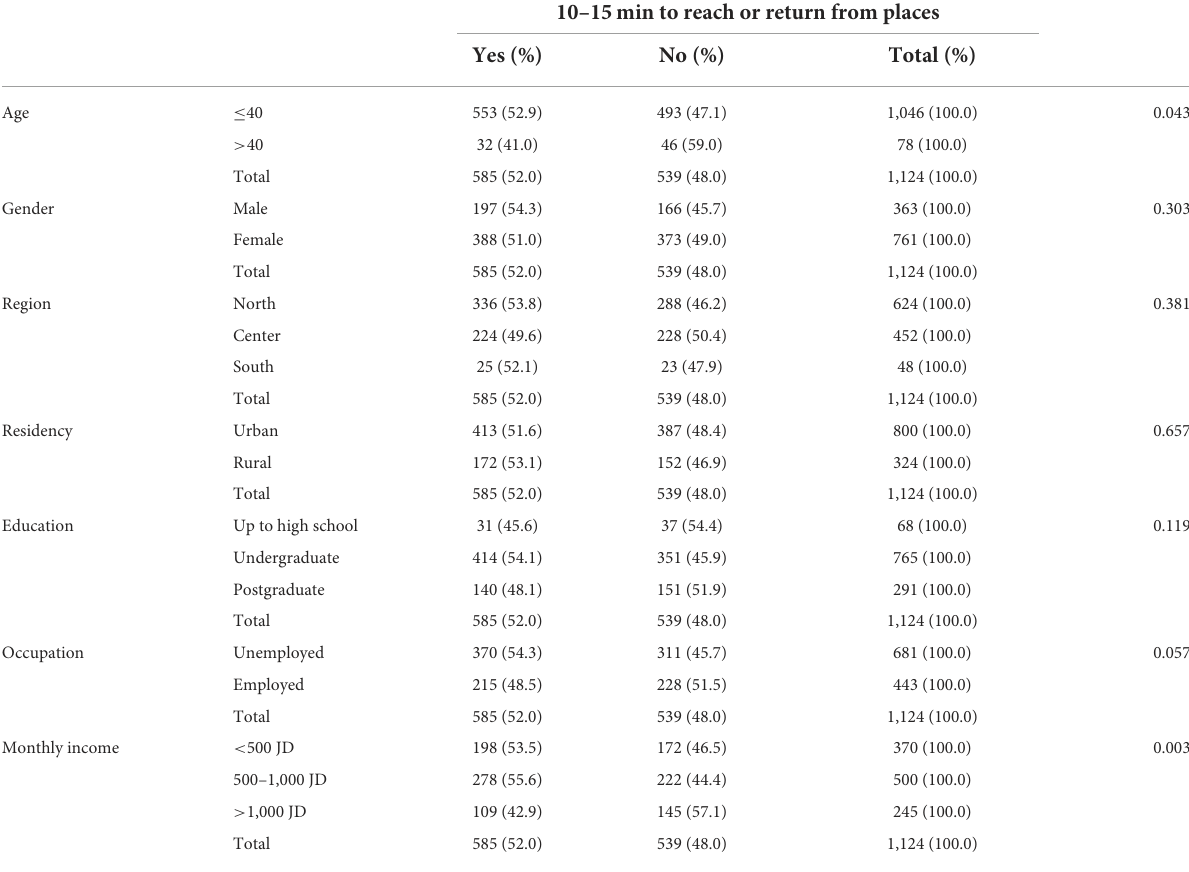
TABLE 2 Distribution of socio-demographic variables by walking and biking practices of study participants ( N = 1,124).